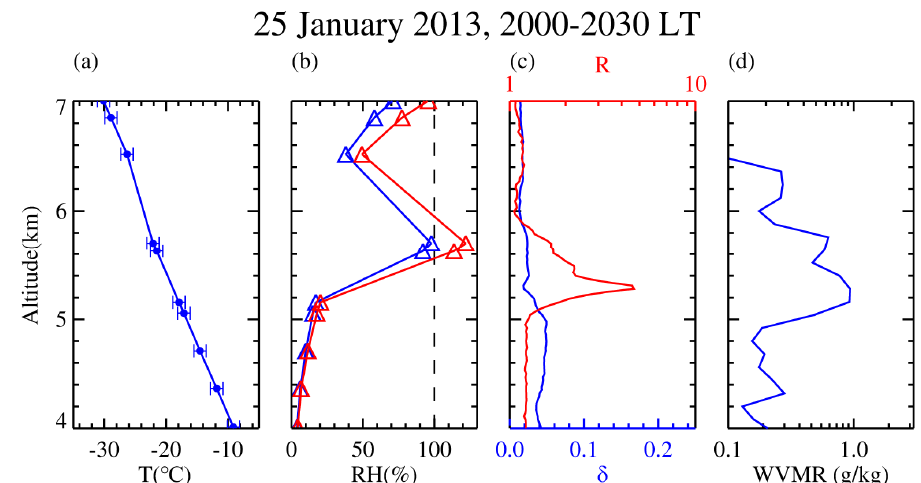
Figure 3. Profiles of ( a ) temperature T, ( b ) relative humidity (RH) over liquid water (blue) and over ice (red), measured by radiosonde launched around 2000 LT on 25 January 2013, ( c ) backscatter ratio (red) and depolarization ratio (blue) obtained by the polarization lidar, and ( d ) water vapor mixing ratio obtained by the Raman lidar during 2000-2030 LT. The WVMR is not shown at altitudes above 6.5 km because of a low signal-to-noise ratio (SNR).